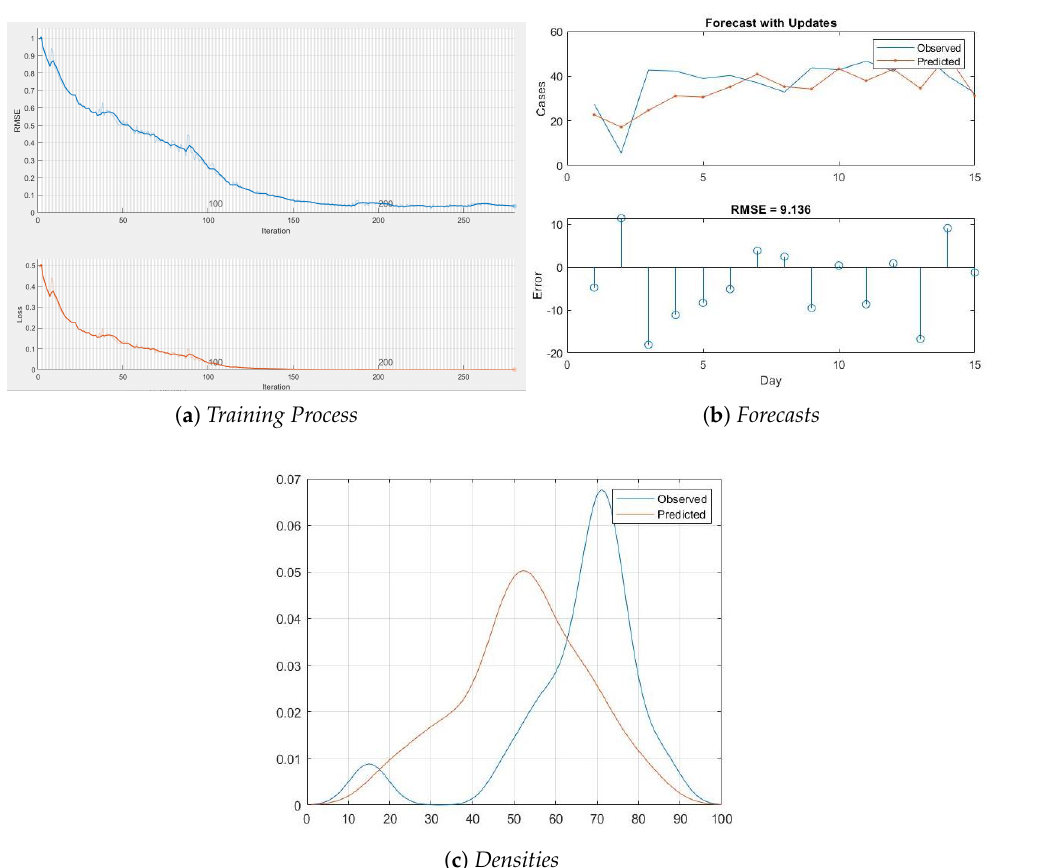
Figure 18. Summary of results of LSTM network on spring/summer period for two weeks forecast.